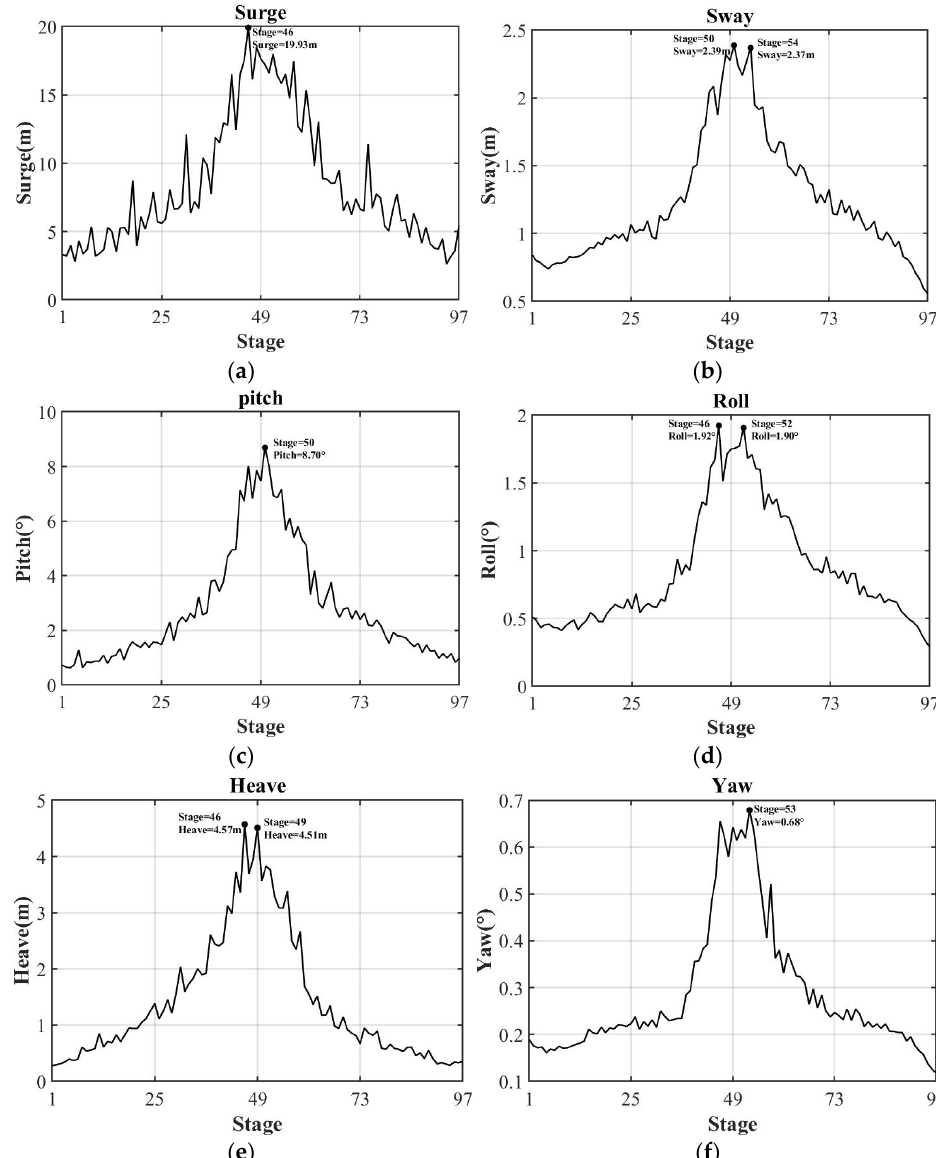
Figure 14. Maximum motion response at different stages: ( a ) Surge, ( b ) Sway, ( c ) Pitch, ( d ) Roll, ( e ) Heave, and ( f ) Yaw.